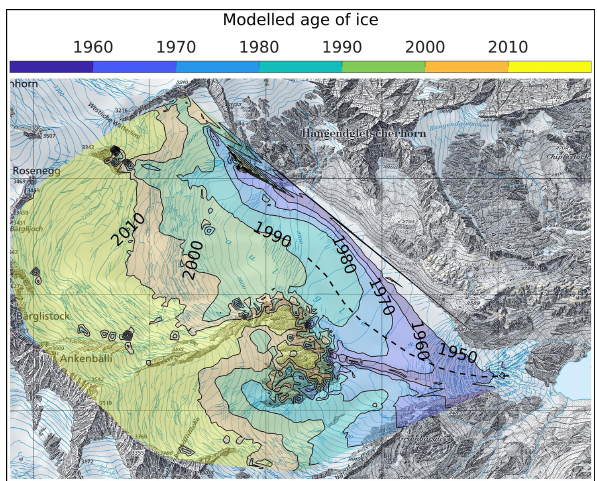
Figure 9. Topographic map of Gauligletscher with 1km grid spac- ing showing the modeled age of ice at the surface using the best- guess model run (Fig. 4). The dashed line shows the line of maxi- mal observed velocities along each lateral transect. Reproduced by permission of swisstopo